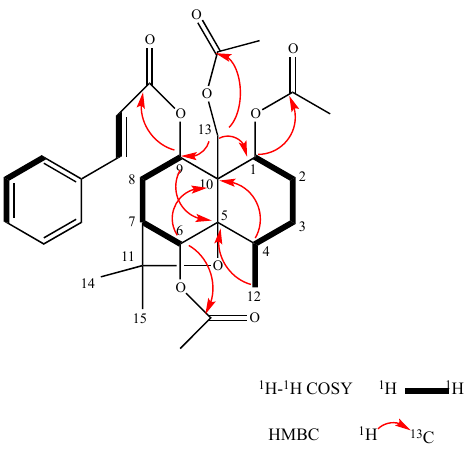
Figure 2. 1 H ‐ 1 H COSY (bold) and selected HMBC (arrows) correlations of Compound 1 .